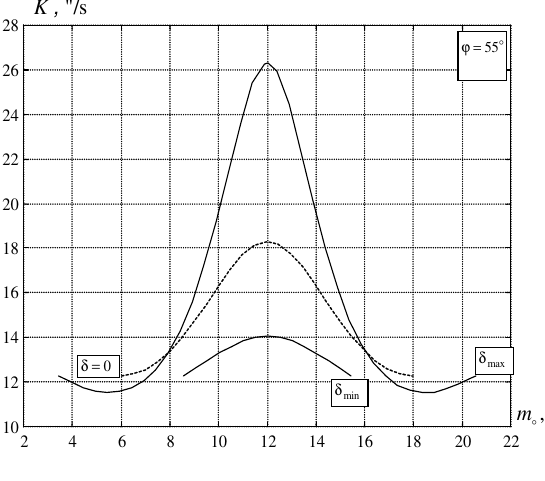
Fig 2. Daily variation of K